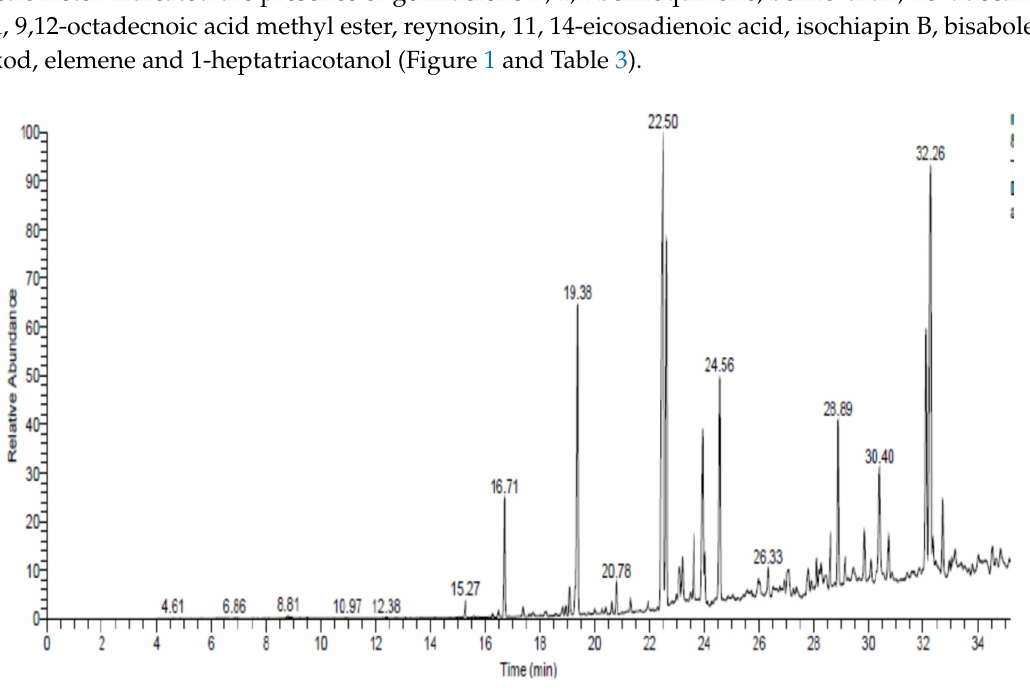
Figure 1. The spectrum of identified compounds from Commiphora myrrha resin ethanolic extract by using Trace GC1300-TSQ mass. Commiphora myrrha resin ethanolic extract were prepared and phytochemically analyzed using Trace GC1300-TSQ